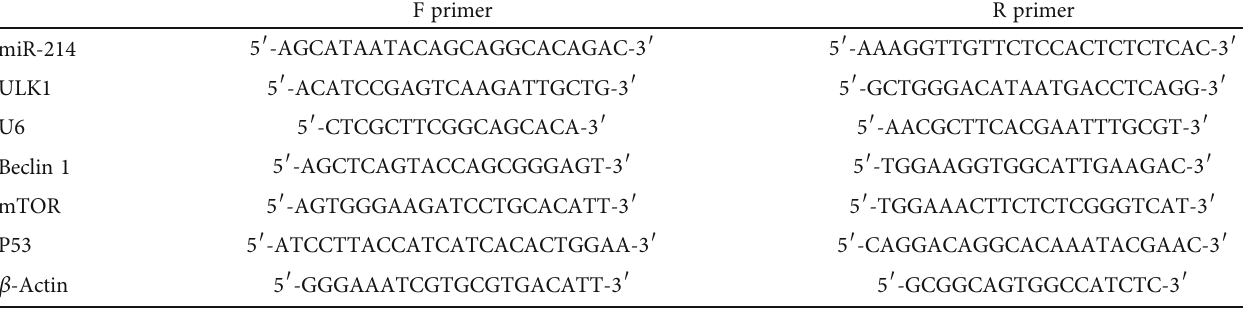
Table 1: Primers information of PCR.